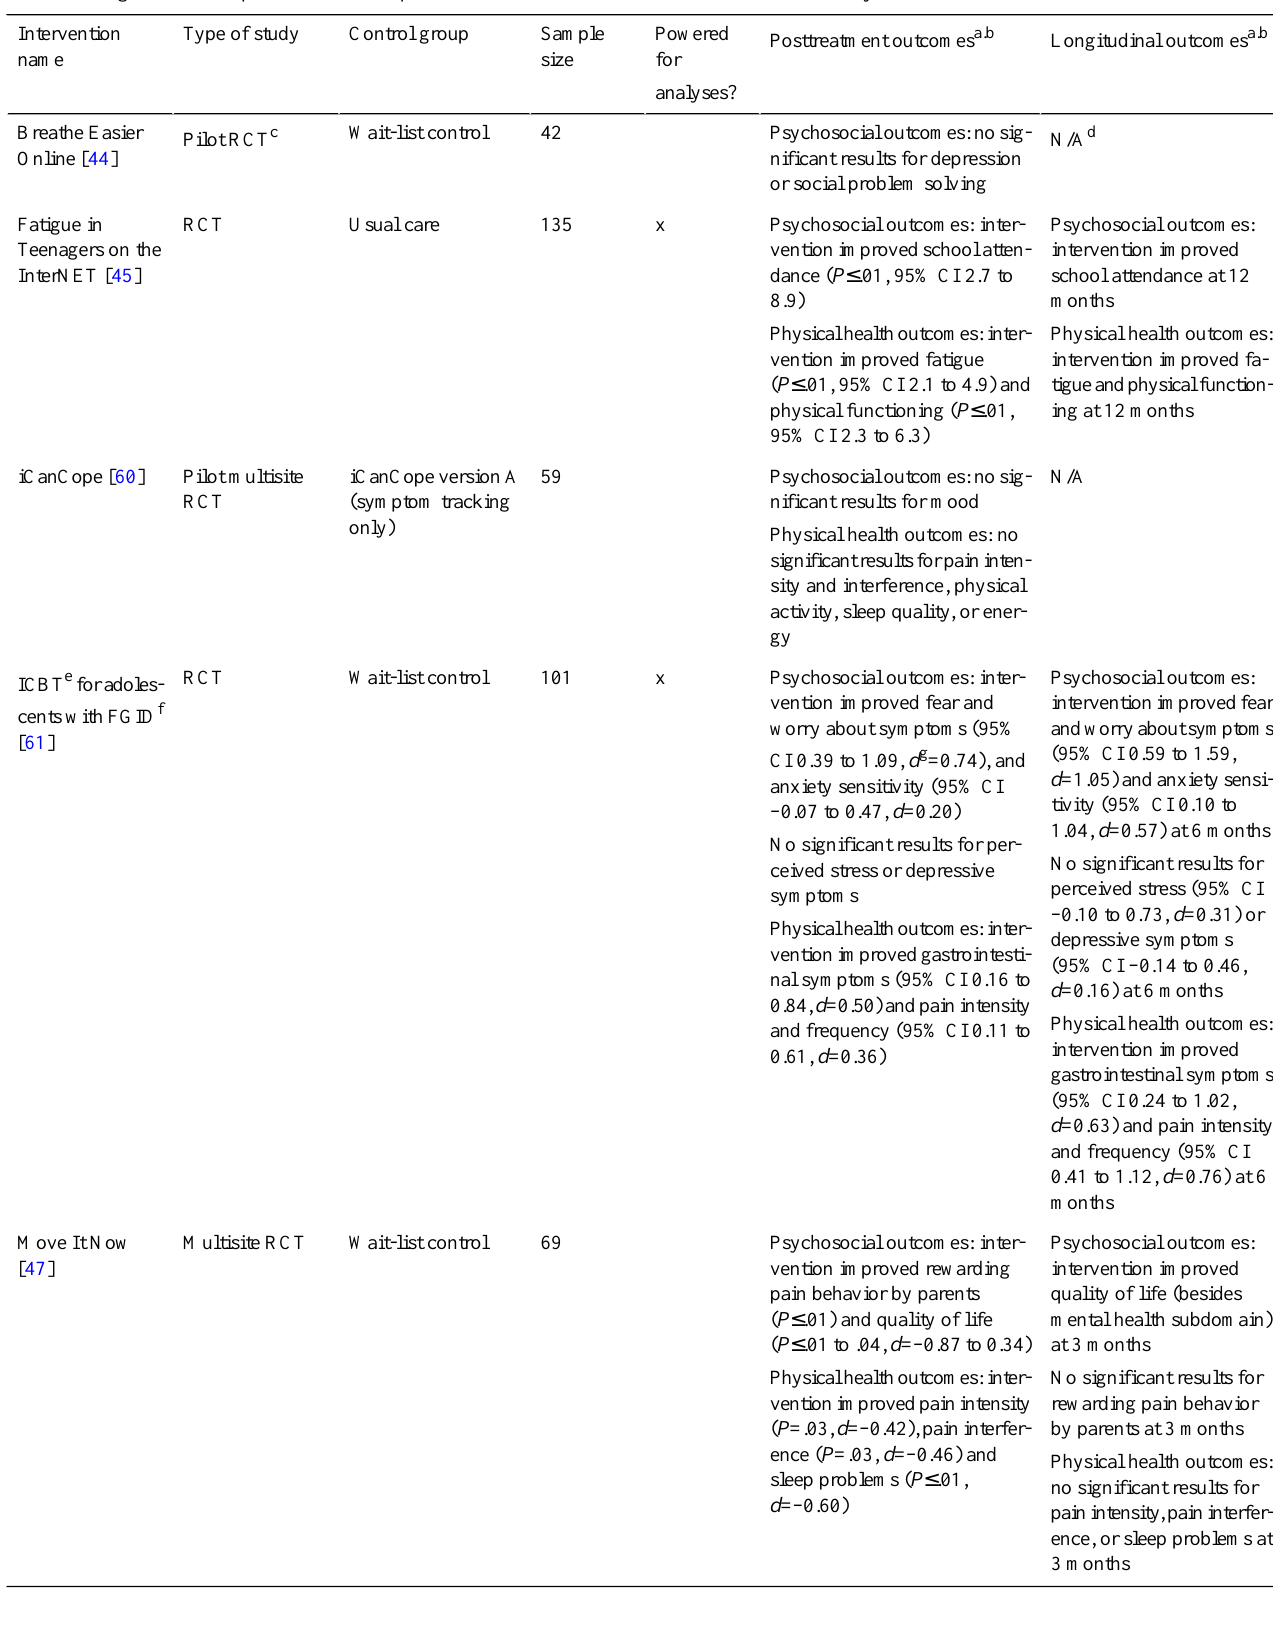
Table 2. Original research publications with quantitative outcomes: randomized controlled trials